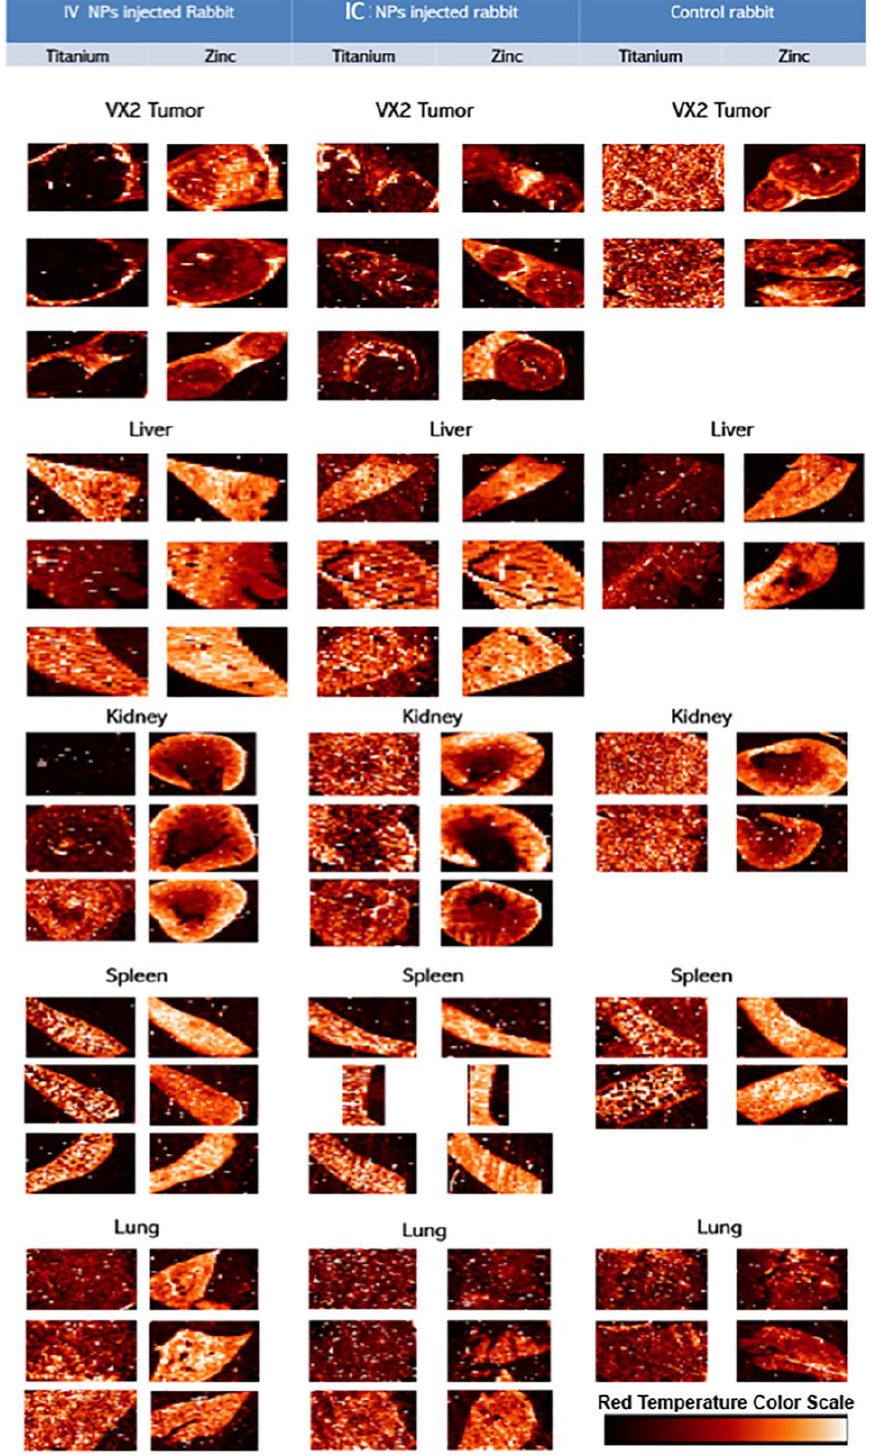
Figure 5. Overview of XFM images for NP distribution after intravenous (IV) and transarterial intra-catheter (IC) injections into control rabbits VX2 tumor and liver, kidney, lung, and spleen tissues. The mapping for the Titanium ( left ) and Zinc ( right ) concentrations and content informs about tissue shape, and potentially even its health status. It should be noted that these are false color images showing distribution of elemental concentrations from the lowest ( black to brown ) to highest ( yellow to white ) within the elemental concentrations distribution of each sample (see color scale bar in lower right depicting spectra of colors matching lowest concentration (in a given sample)—black) to highest ( white ) across a “red temperature” scale. Thus, samples with very low elemental concentrations for a given element (e.g., Ti in control samples) show a “salt and pepper” pixel distribution indicating that